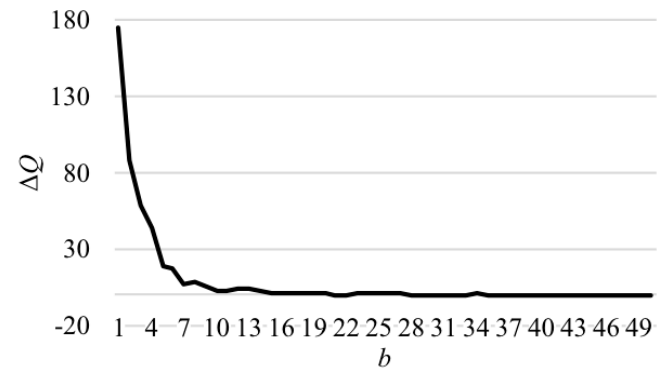
Figure 2. Absolute error for approximate division of P − 1 by b with RNS moduli set {5, 7, 9, 11} and N = 17.